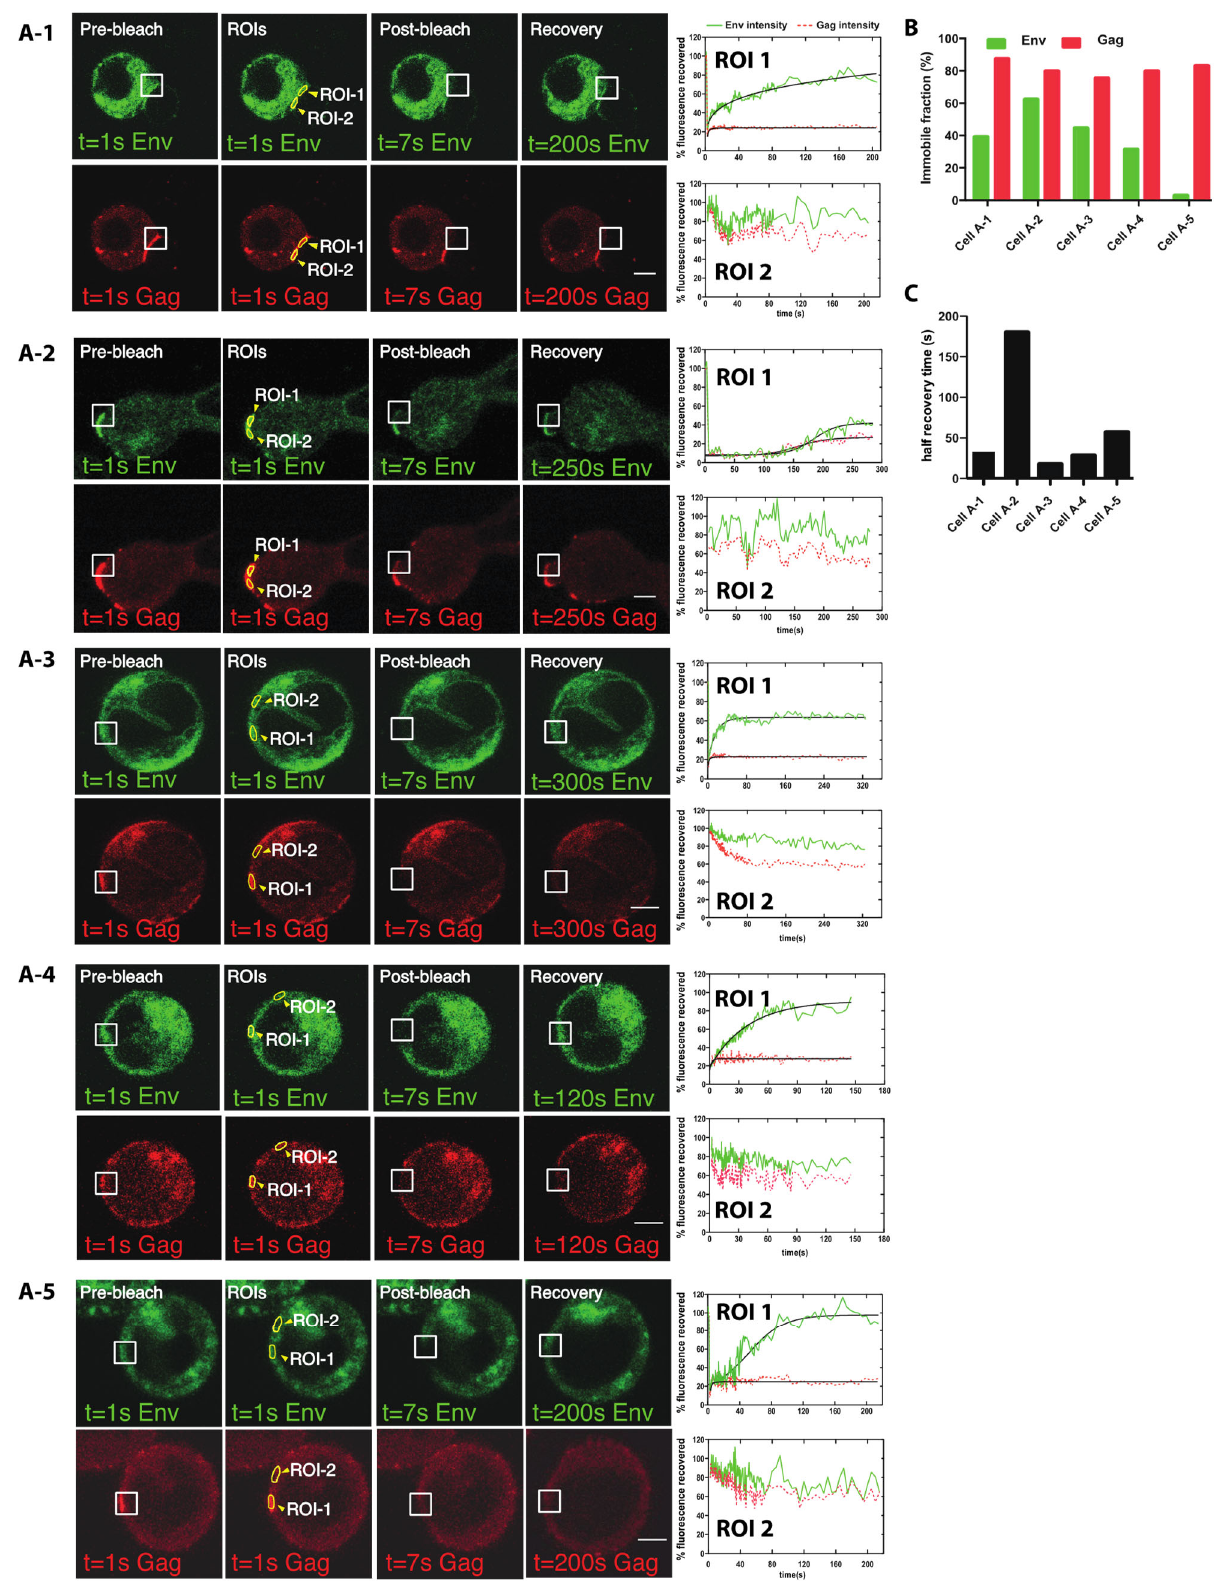
Figure 5. Rapid Env fluorescence recovery after photobleaching was observed at the VS. CD4+ T cell line Jurkat was nucleofected with HIV Env V4.2 sfGFP ‐ Gag ‐ iCherry and mixed with primary CD4 T cells and allowed to form VSs. Established synapses where Gag and some level of Env was observed at cell–cell contacts were selected for FRAP imaging. ( A1 – A5 ) Before photobleaching (left panels) a virological synapse with both Gag and Env could be observed between a donor